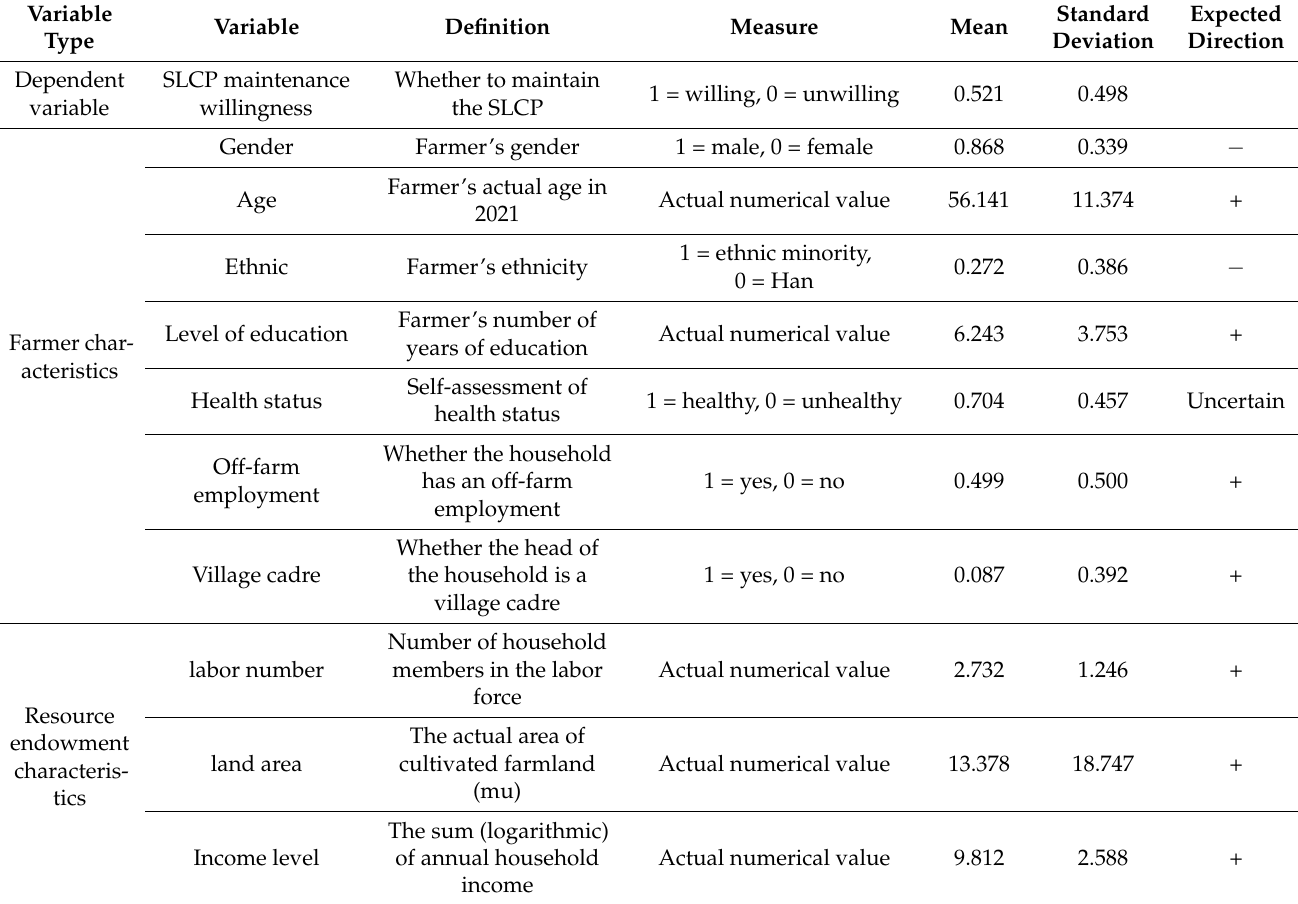
Table 2. Descriptive statistics of the